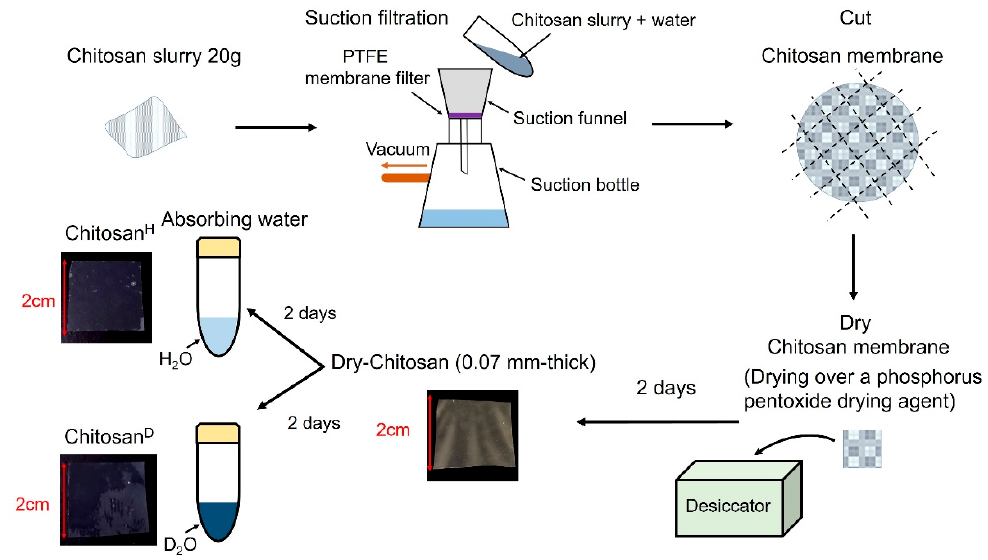
Figure 1. Preparation process employed to obtain the Dry-Chitosan, Chitosan D , and Chitosan H spec- imens.